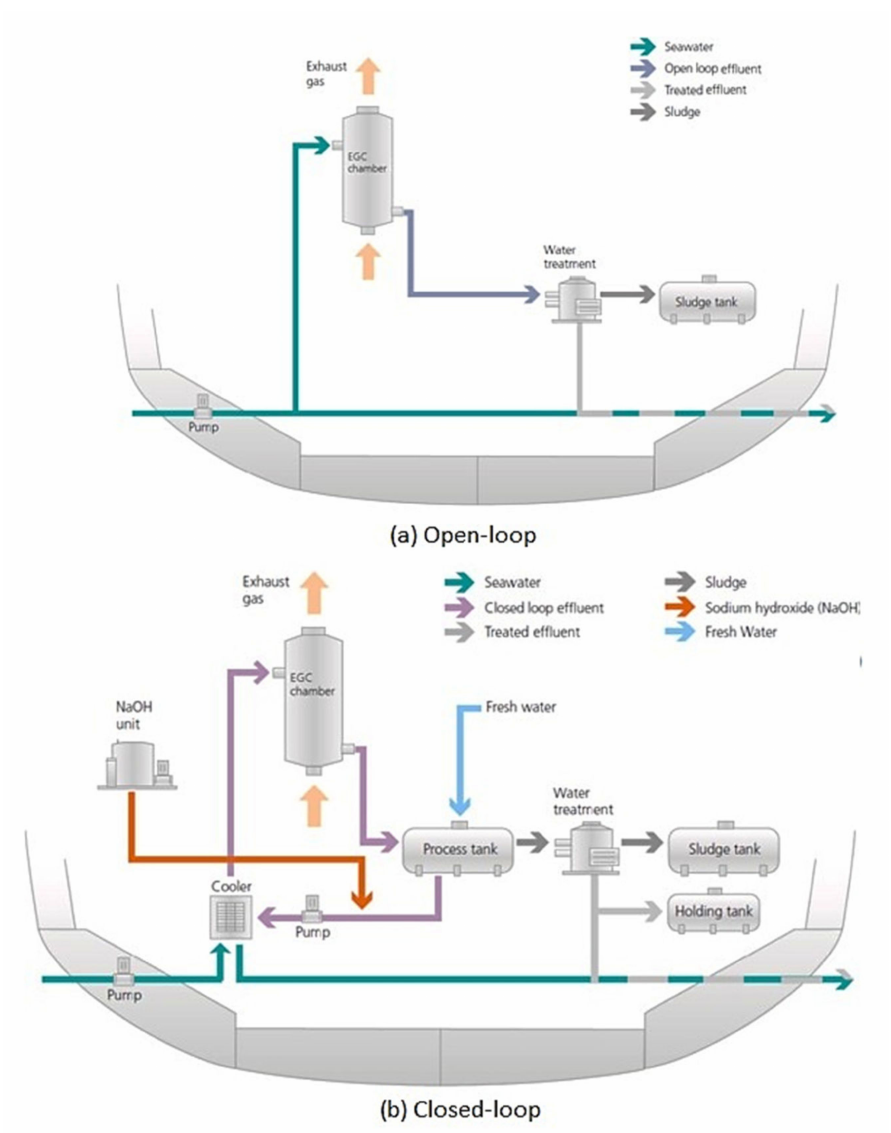
Figure 2. Structure of open-loop and closed-loop scrubbers